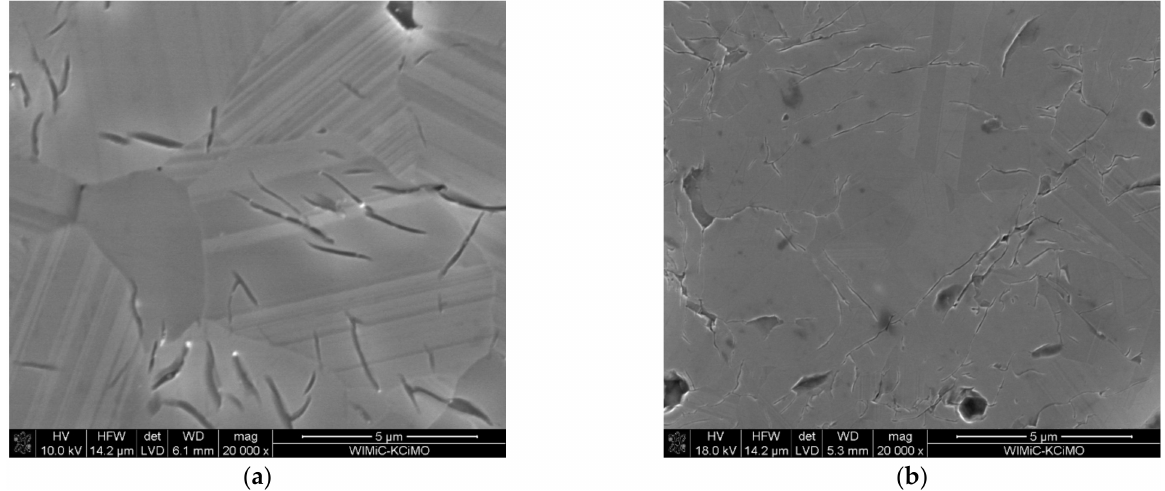
Figure 12. SEM microstructures of samples with B:C = 10:1 composition: ( a ) sintered under 25 MPa pressure to a final temperature of 1850 ◦ C and ( b ) sintered without external pressure to 1550 ◦ C and then under 25 MPa pressure to 1850 ◦